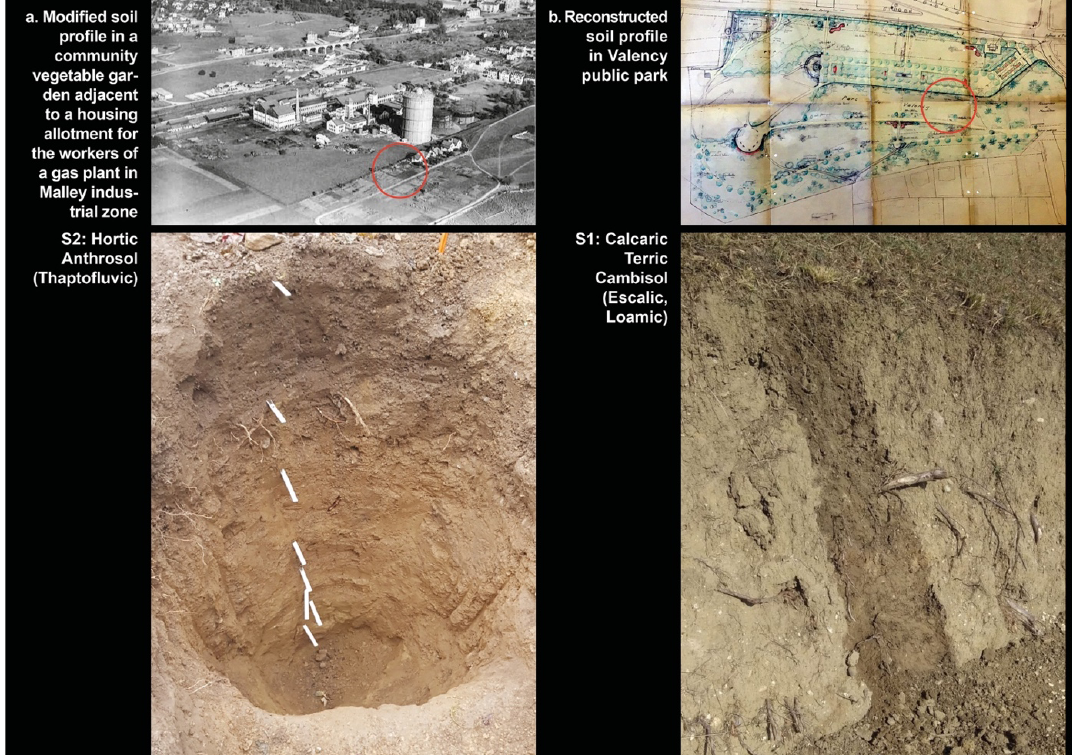
Figure 9. First half of the 20th century: Soil profiles, accompanied by historical source documents illustrating the urban- ization processes which produced them. Source: Authors, based on photos and archival sources provided by